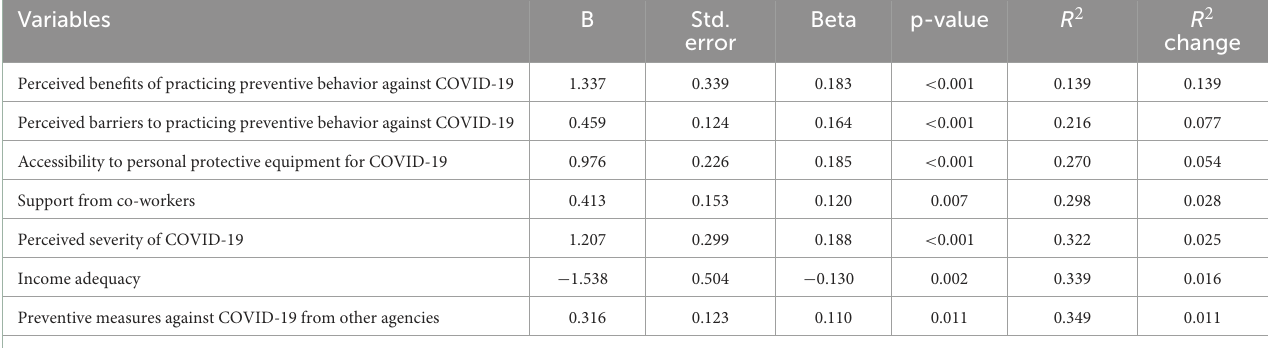
TABLE 7 Coefficient multiple regression of factors in predicting the preventive behavior of COVID-19 among taxi drivers in Bangkok.